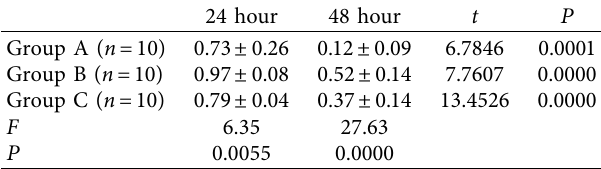
Table 1: The protein levels of hypoxia factor.